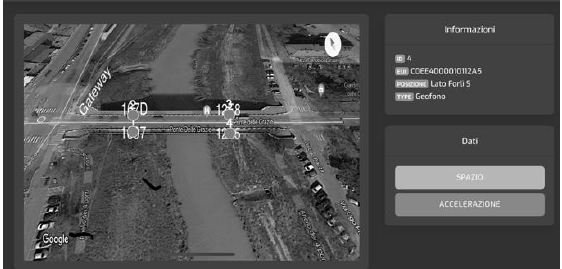
Figure 10. user interface to handle geophone sensors.